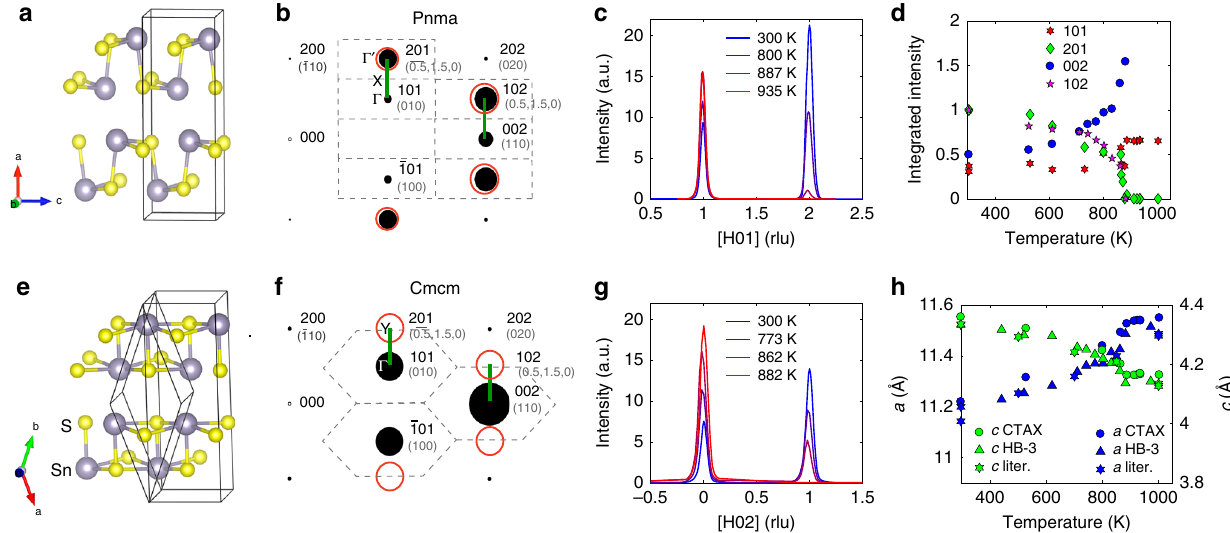
Fig. 1 Crystal structure and phase transition. a , e Crystal structures for the Pnma and Cmcm phases of SnS. b , f Neutron-weighted reciprocal space maps for the Pnma (300 K) 57 and Cmcm (1000 K) 11 phases in the ( H 0 L ) plane (conventional Pnma cell). Bold Miller indices are in Pnma notation, while those enclosed in parentheses are in primitive Cmcm notation. Brillouin zones for the conventional Pnma and primitive Cmcm cells are indicated by the dashed gray outlines, together with X and Y points, in ( b ) and ( f ), respectively. Superstructure Bragg peaks disappearing in the Cmcm phase are circled in red. Green segments correspond to directions measured with TAS. Single-crystal diffraction data on SnS for [ H 01] from CTAX ( c ) and for [ H 02] from HB-3 ( g ). d Evolution of SnS integrated peak intensities (±0.25 H (rlu)) and h lattice parameters (literature data from ref. 11 ) with temperature. In e the rhombohedron shows the primitive cell, while the larger rectangular parallelepiped is the conventional cell. The coordinate system shown in ( e ) is for the primitive cell.